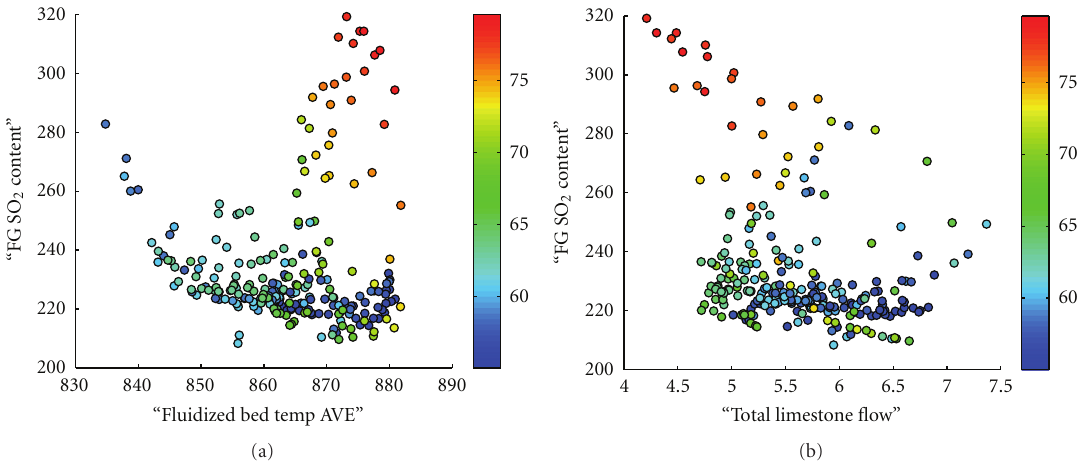
Figure 7: Flue gas (FG) SO 2 content [mg/Nm 3 ], (a) as a function of the bed temperature [ ◦ C] and (b) as a function of the limestone flow [kg/s], by using the reference vectors of SOM neurons in the process state of high-steam flow . Color scale indicates the deviation of the furnace middle level temperature [ ◦